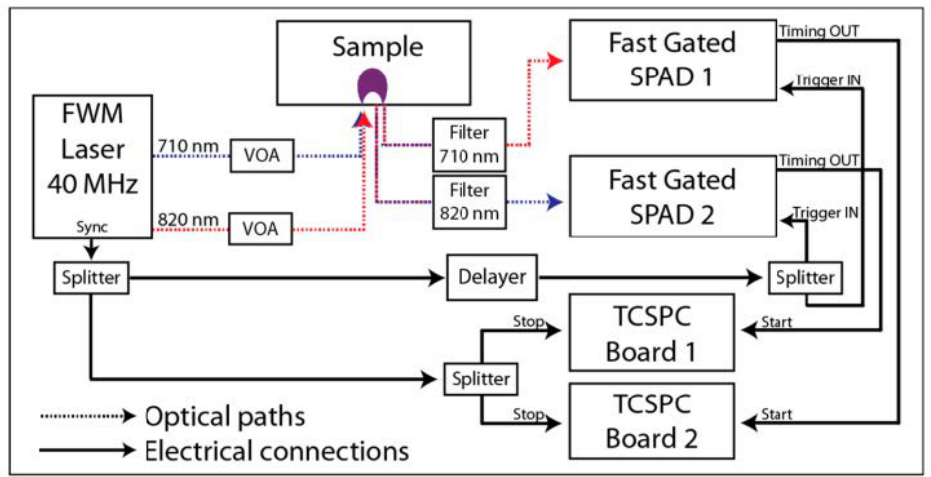
Figure 18. Setup schematics for the in vivo experiment. Reproduced from reference [101].